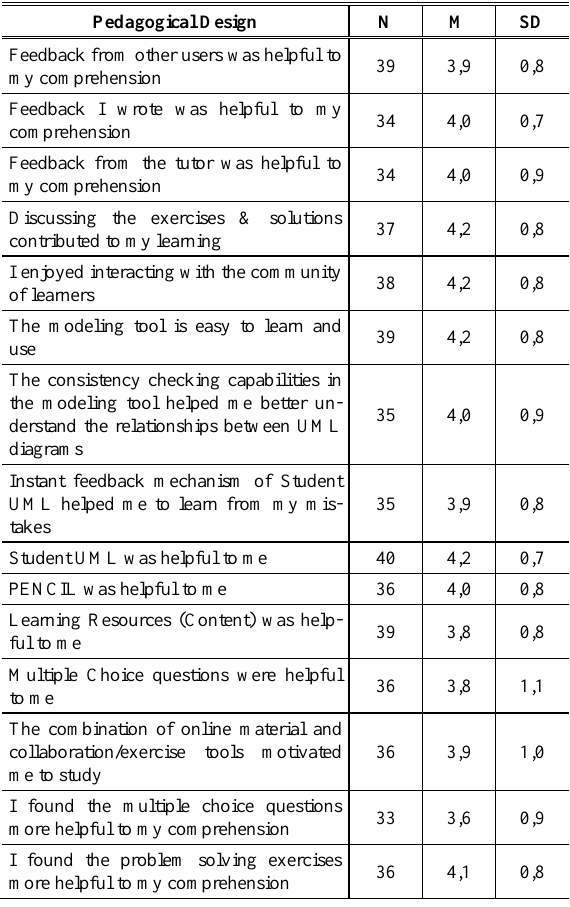
TABLE II. E VALUATION RESULTS CONCERNING PEDAGOGICAL DESIGN . N=N UMBER OF RESPONSES , M=M EAN , SD=S TANDARD DEVIATION . Pedagogical Design